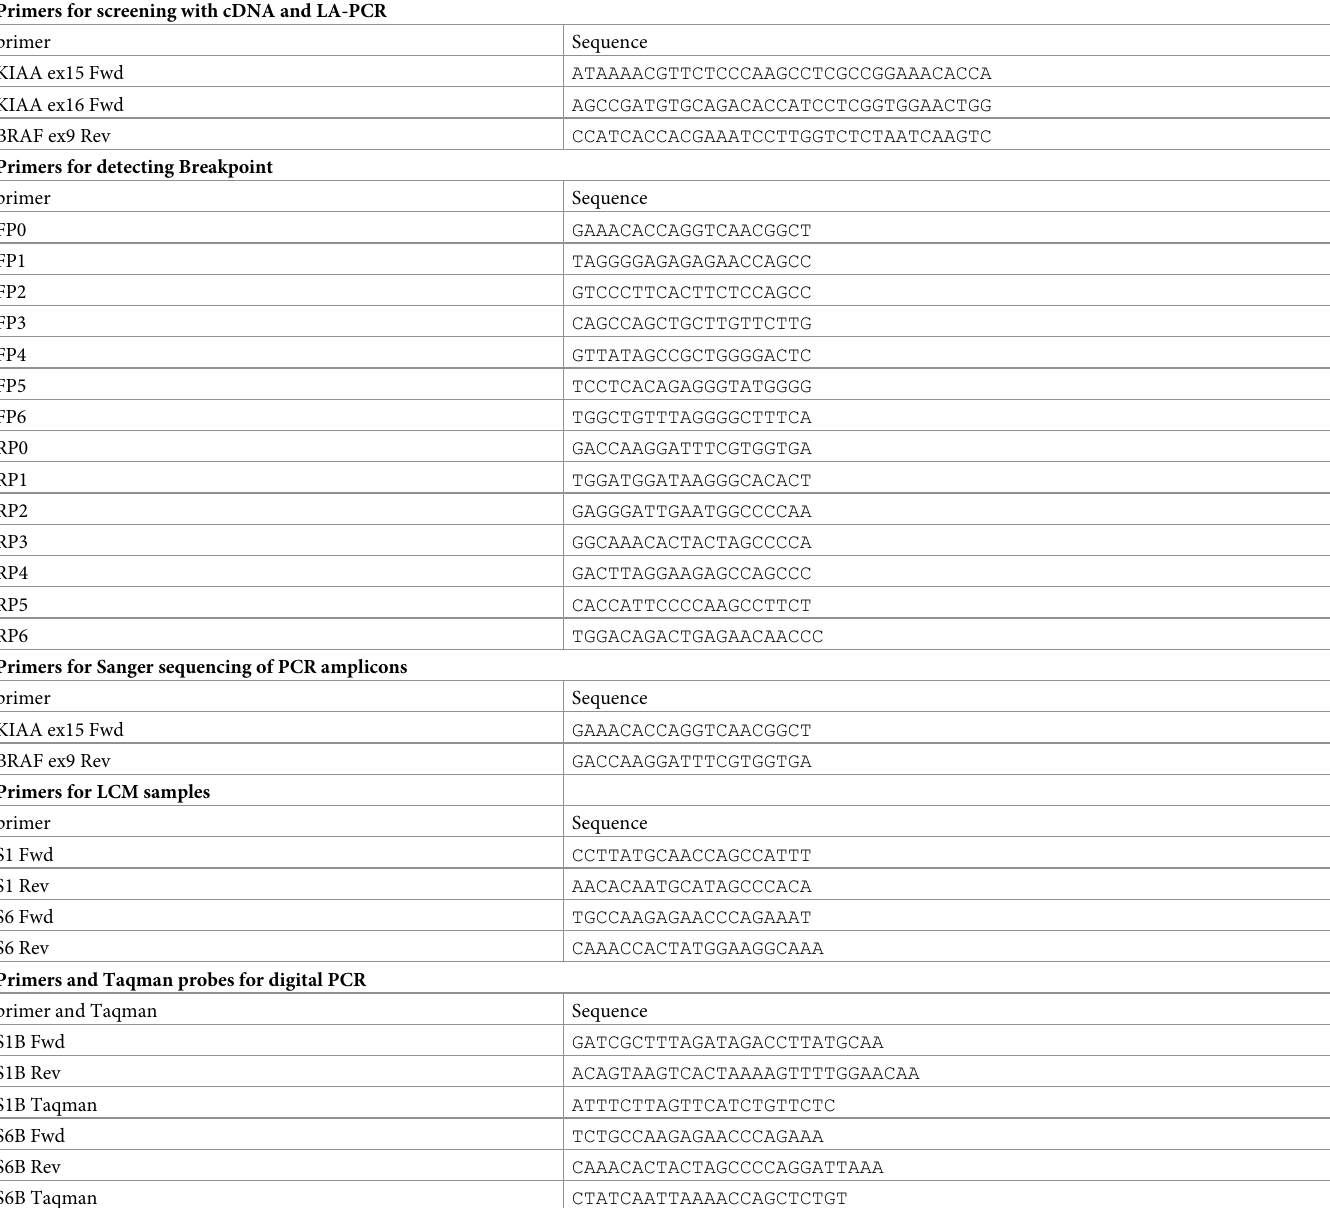
Table 2. Primer sequences. Primers for screening with cDNA and